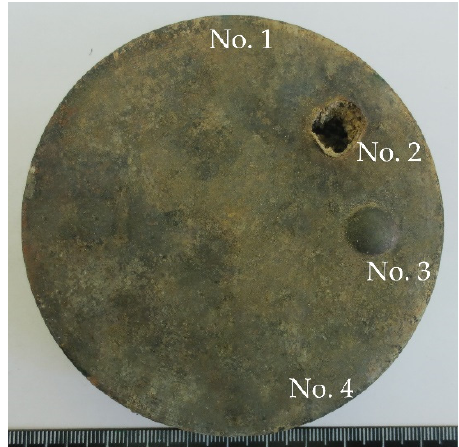
Figure 11. Matrix with the specimens (of compositions No.1–4) after shock-wave loading (top view).